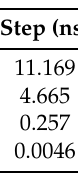
Table 2. Measurement results of step/range of tuning stage.